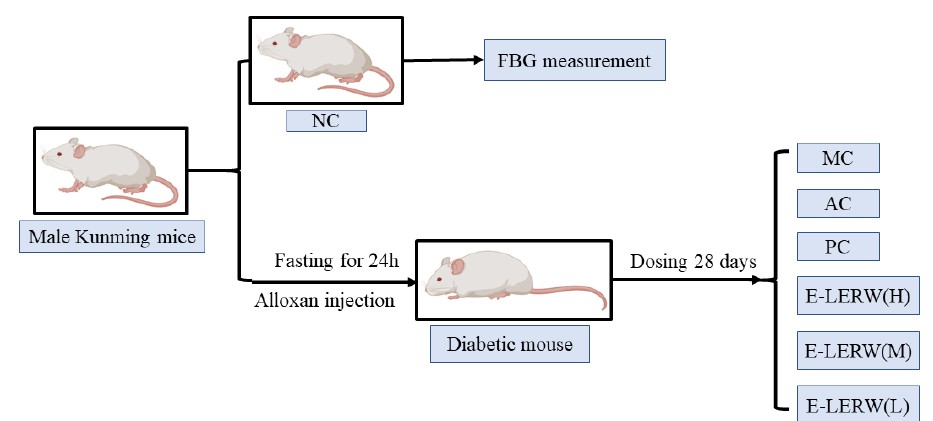
Figure 1. The scheme of animal experimental design. NC: The normal control of mice without alloxan injection. MC: The model control of diabetic mice without any treatment. PC: The positive control of mice treated with metformin. AC: The control of mice treated with astilbin (30 mg/kg). E-LERW (H), E-LERW (M), and E-LERW (L): The diabetic mice treated with ethanol extract of leaves of Engelhardtia roxburghiana Wall (E-LERW) at high dose (600 mg/kg), medium dose (300 mg/kg), and low dose (150 mg/kg), respectively. FBG: fasting blood glucose.